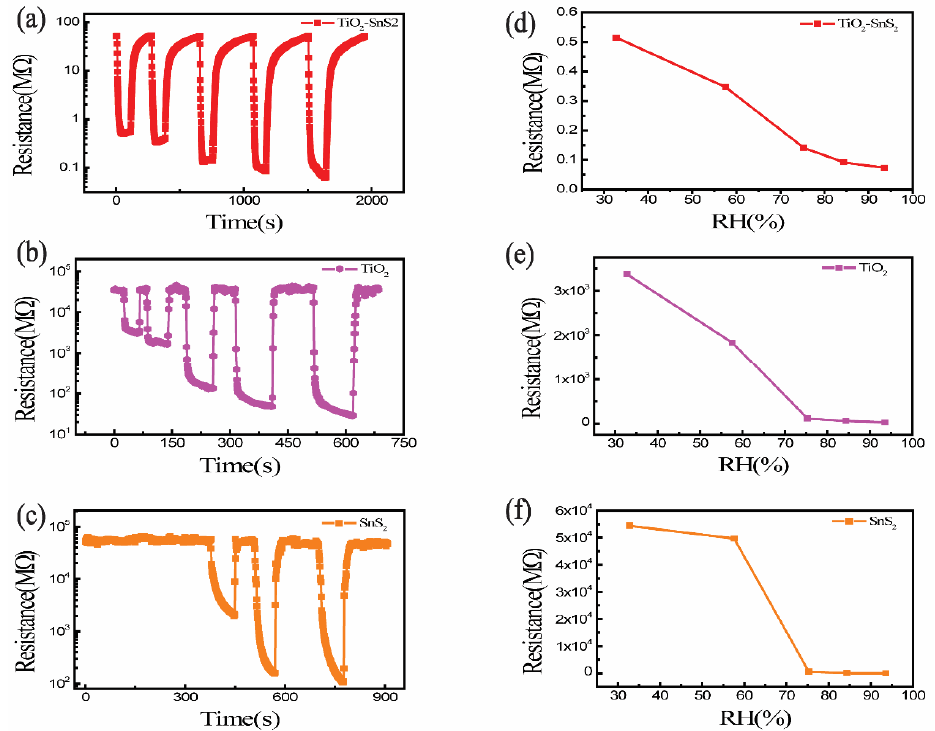
Figure 6. The humid responsivity ( a ) and ( d ) at different RH of TiO 2 -SnS 2 , the humid responsivity ( b ) and ( e ) at different RH of TiO 2 , and the humid responsivity ( c ) and ( f ) at different RH of SnS 2 . Pure TiO 2 and SnS 2 have different responses to humidity, and the composite of the two materials TiO 2 -SnS 2 shows different response mechanisms. First of all, we describe the sensing mechanisms of monolithic components (i.e., pure TiO 2 and SnS 2 ). The mois- ture sensing of TiO 2 is mainly caused by oxygen vacancies [30], and compounds contain-